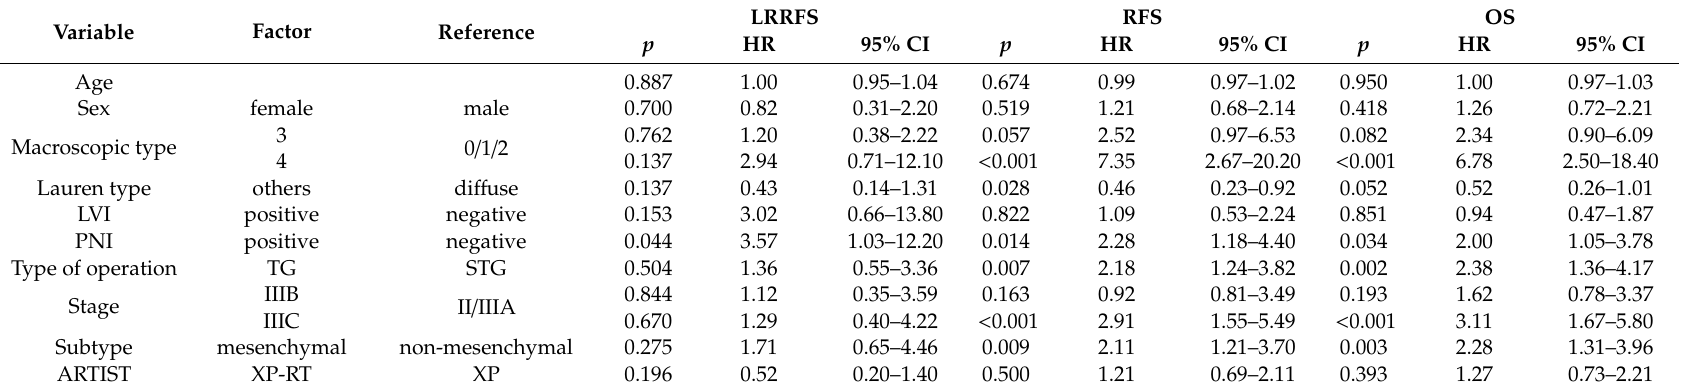
Table 2. Univariate analysis of loco-regional recurrence-free survival (LRRFS), recurrence-free survival (RFS), and overall survival